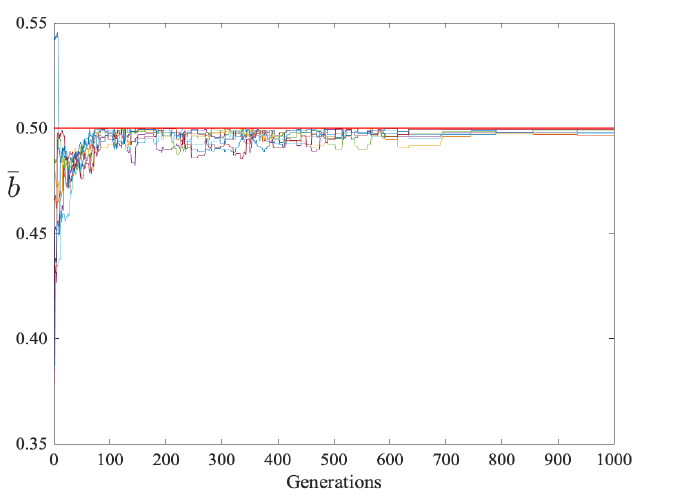
Figure 6. Row sample means versus generations for n = 20 players. There are 20 colored graphs, each showing how a player’s sample mean varied during evolution. The red line is at ¯ d = 0.5.